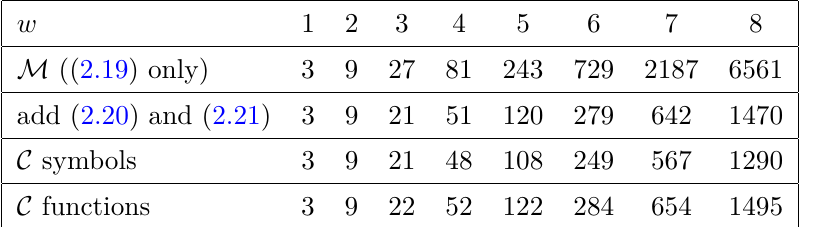
Table 1. Dimension of various possible polylogarithmic spaces, as a function of the weight w . Except for the last row, the numbers are at symbol level. We remark that when lifting C from symbol to function level, a few symbols have to be removed, starting at weight 6; if one were to compute the symbol of the C function space, one would find only 246, 555, 1251 independent symbols at weights 6, 7, 8.